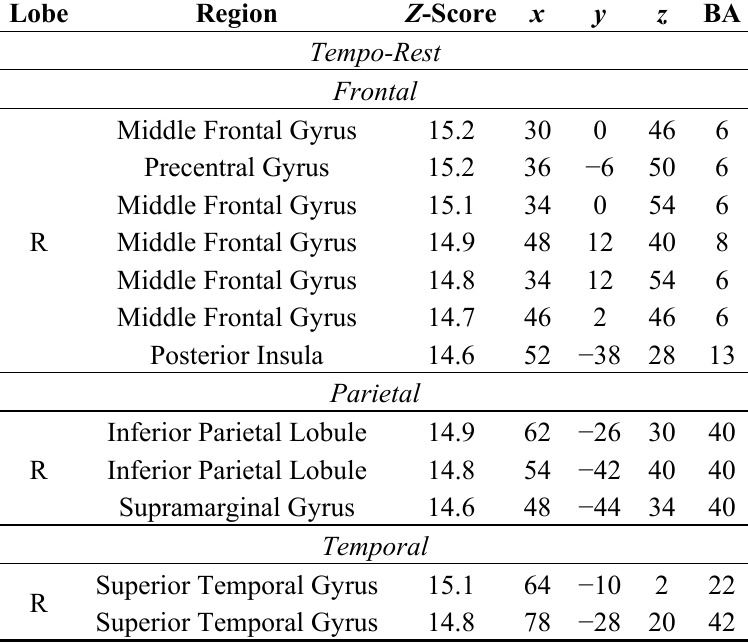
Table 4. Stereotactic MNI coordinates, Z -score values, and anatomical and Brodmann areas for activations during the Tempo condition contrasted to